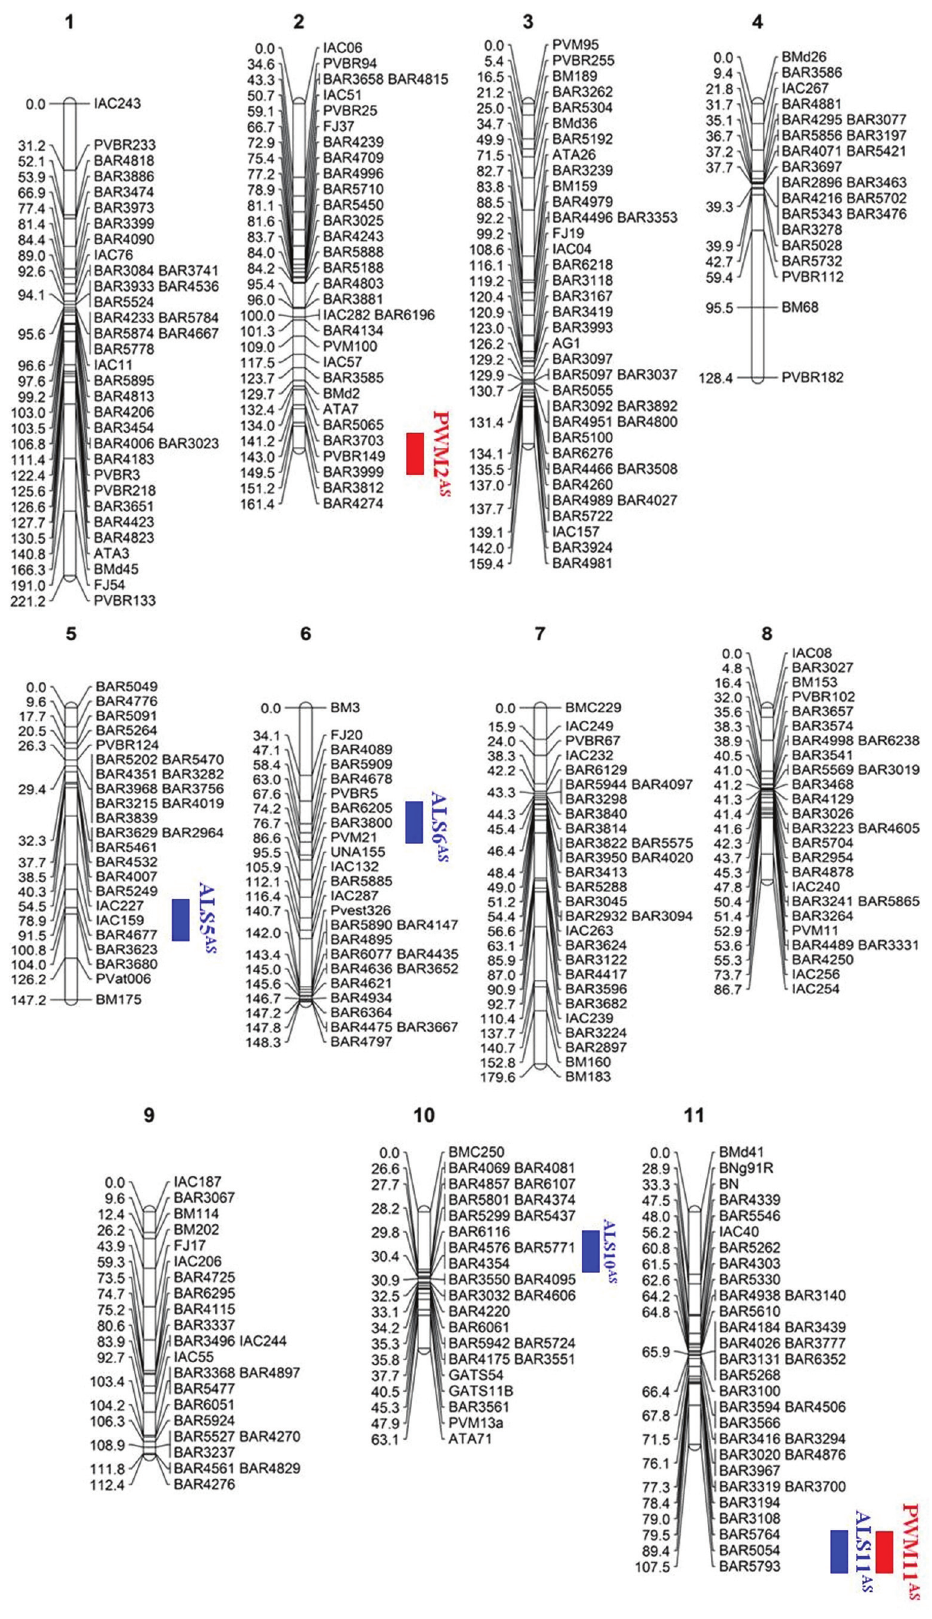
Figure 1 - Genetic map for common bean derived from linkage analysis between 79 SSRs and 252 SNPs. Red bars indicate powdery mildew resistance QTLs while blue bars represented angular leaf spot resistance